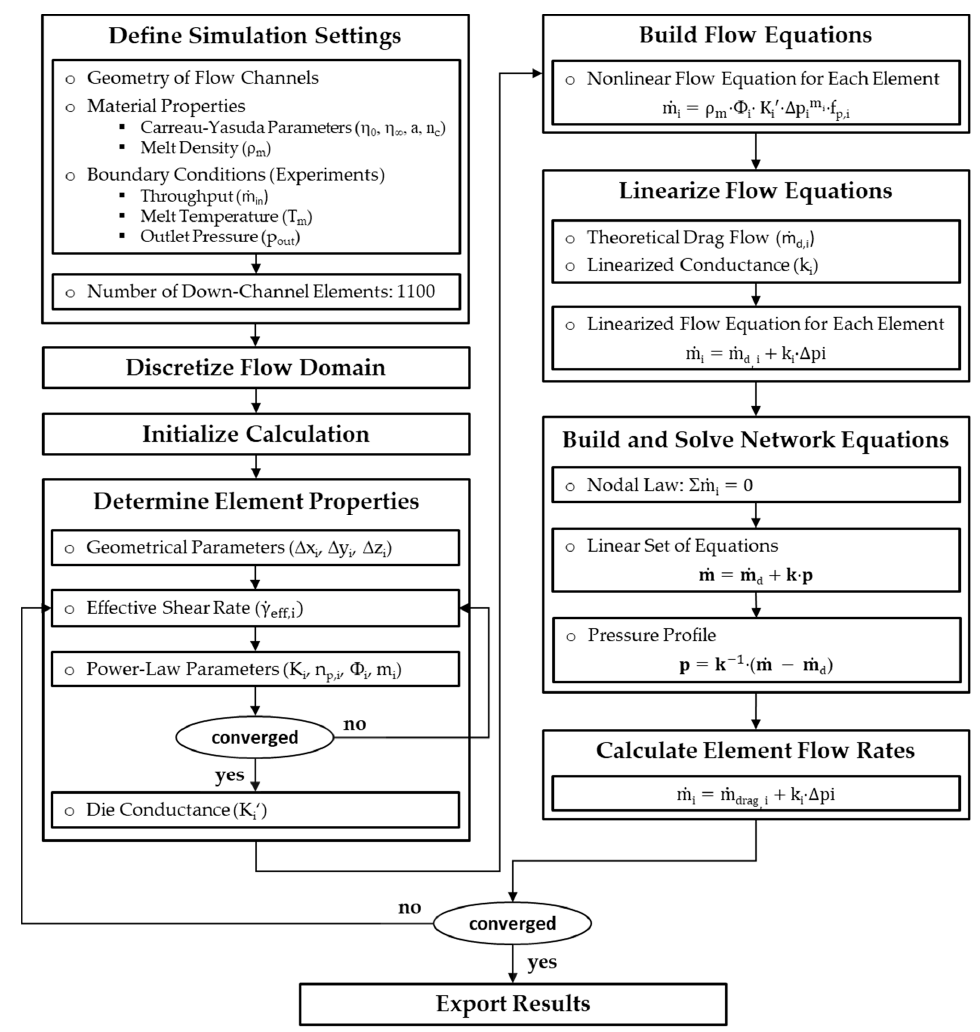
Figure 9. Flow chart of our seminumerical modeling approach based on network theory.